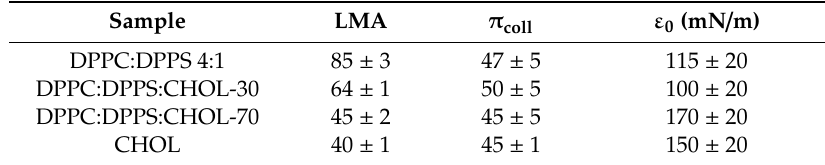
Table 5. Limiting molecular area LMA, collapse pressure ( π coll ), and maximum Gibbs elasticity ( ε 0 ) values of DPPC:DPPS:CHOL monolayers spread onto LaCl 3 2.5 mM (Figure 1D). Sample